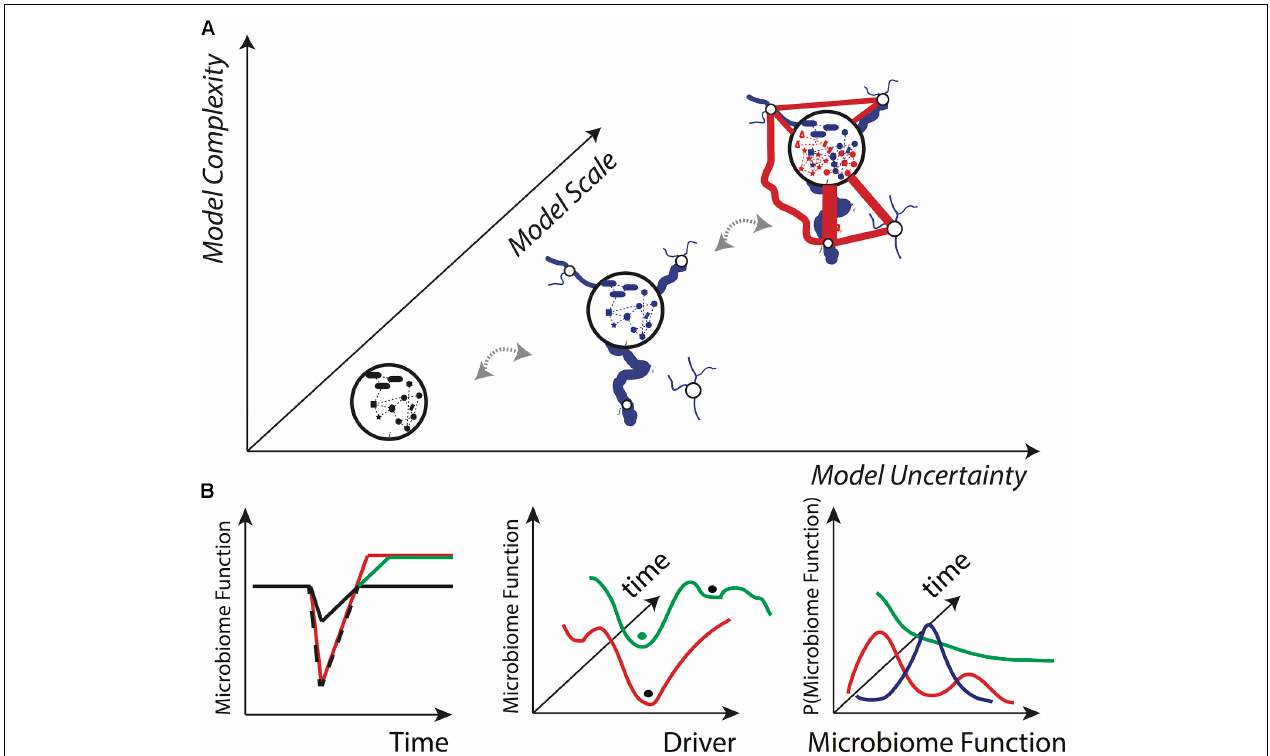
FIGURE 3 | Conceptual model complexity-uncertainty-scale manifold and desirable model outputs. (A) According to general computational complexity principles, it is expected that microbiome uncertainty (information) grows with the spatio-temporal scale of analysis and the complexity of the system (data) analyzed. These principles are independent of model and microbial systems. The scale is the biological, spatial and/or temporal level of analysis and defines the sensitivity (variability) of the model. For instance, at micro-, meso-, and macro-scales the analysis can be at the individual, population and multi-population level. The scale also defines information complexity that may be related to potentially causal networks for the microbiome such as natural and human spreading networks (in blue and red). Each node of the community details a microbiome interaction network or graph. (B) Three outputs of general interest in microbiome research for assessing systemic risk and resilience that have an increasing focus on systemic properties, from left to right: microbiome feature value over time (e.g., function), microbiome feature state-space over a gradient of drivers, and systemic probability distribution of microbiome features under different